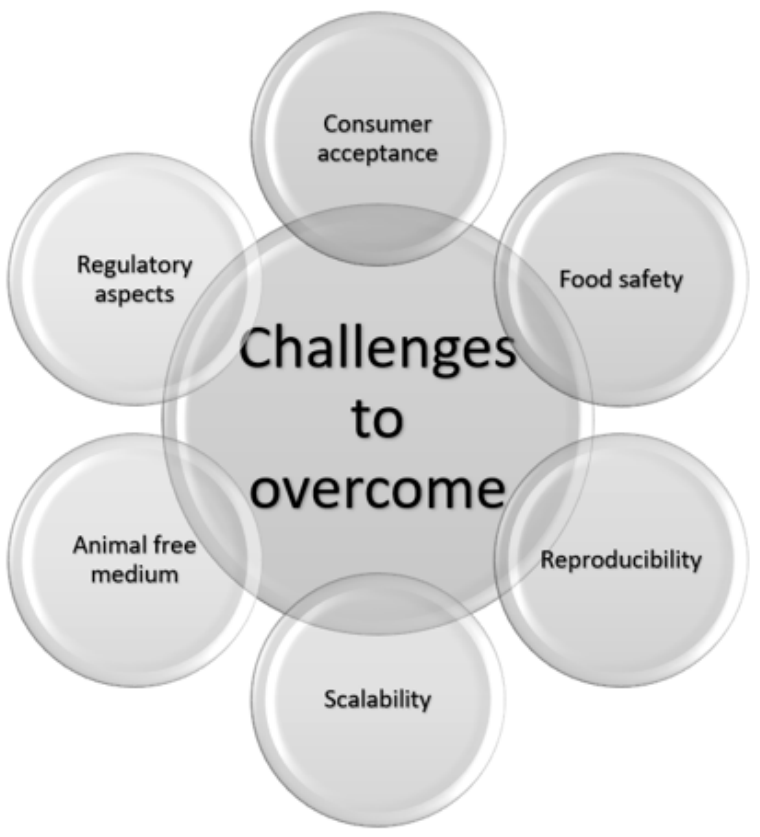
Figure 1. The technological and social challenges that must be overcome before cultivated meat is available on a large